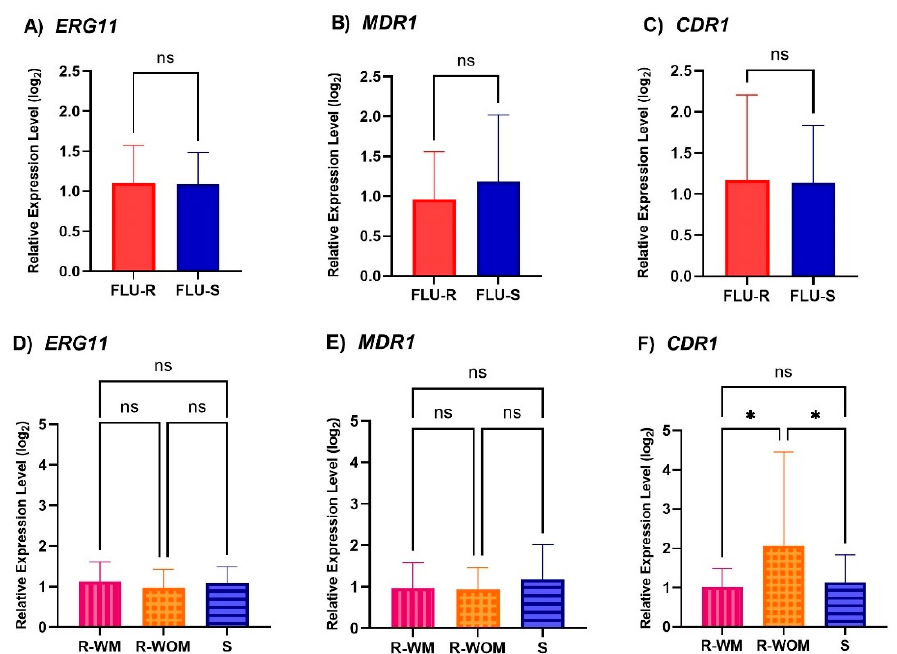
Figure 2. ( A – C ) The relative expression level of ERG11 , MDR1 , and CDR1 genes of fluconazole resistant isolates; FLU-R, and fluconazole susceptible isolates; FLU-S. ( D – F ) The relative expression level of ERG11 , MDR1 , and CDR1 genes comparisons among the resistant isolates with detected mutations; R-WM, the resistant strains without detected mutations; R-WOM, and the susceptible isolates; S. The results were performed in technical triplicates. Values are expressed as the mean ± standard deviation. * indicates statistically significant ( p < 0.05) whereas ns means non-significant